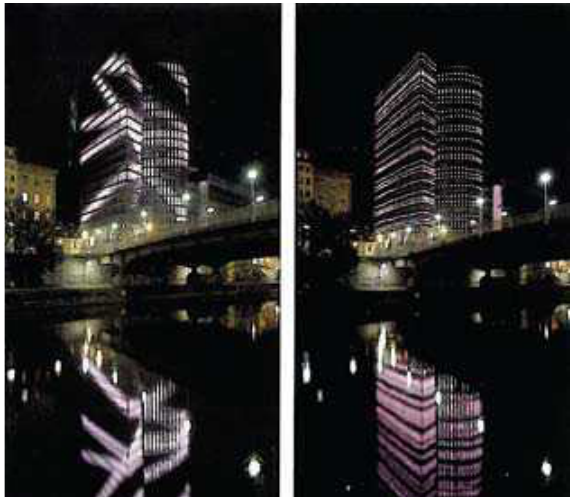
Fig. 14. Uniqua tower in Vienna 2008. archs. Neuamann &